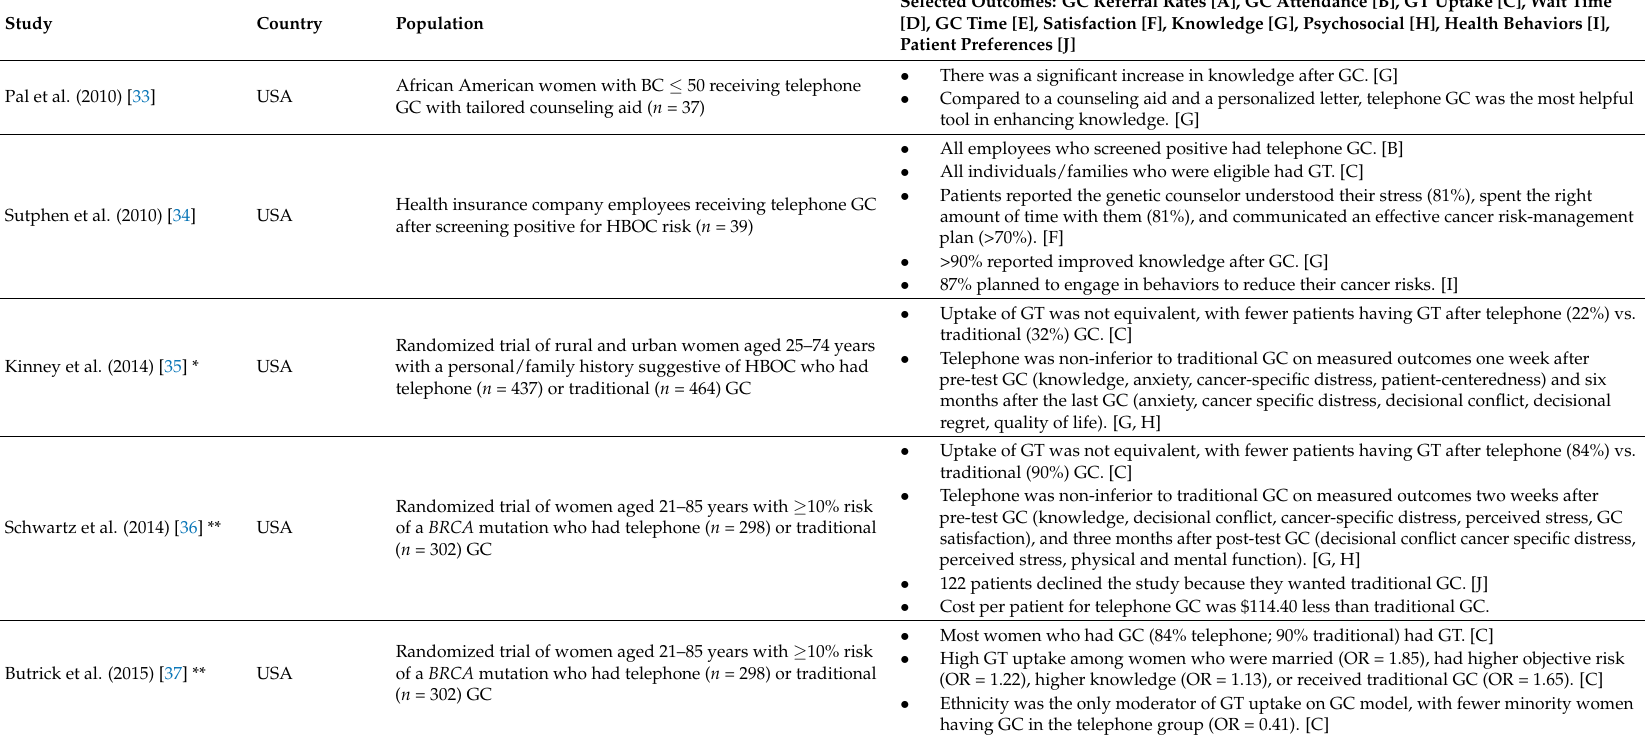
Table 1. Telephone genetic counseling